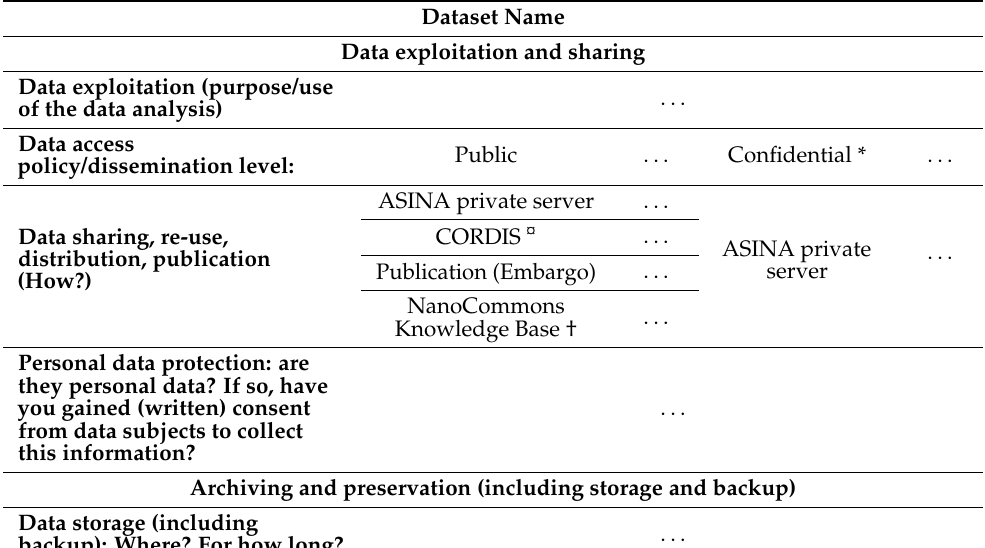
Table 2. Addressing data confidentiality among partners in the data management